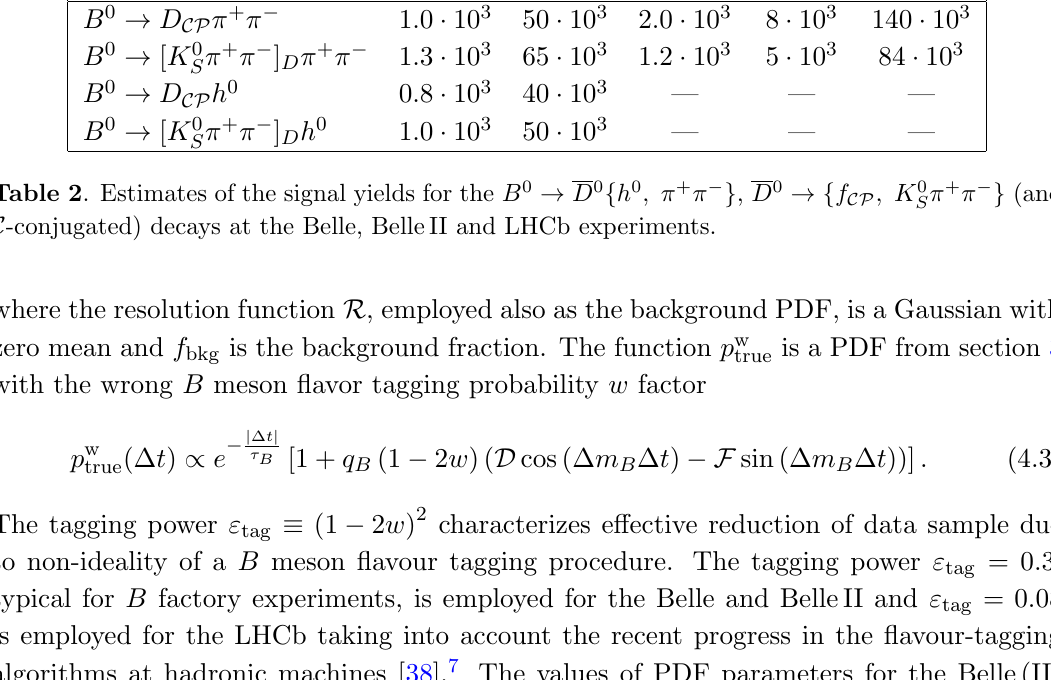
D 0 h 0 ; (cid:25) + (cid:25) (cid:0) , D 0 f CP ; K 0 (cid:25) + (cid:25) (cid:0) (and S ! f g ! f g